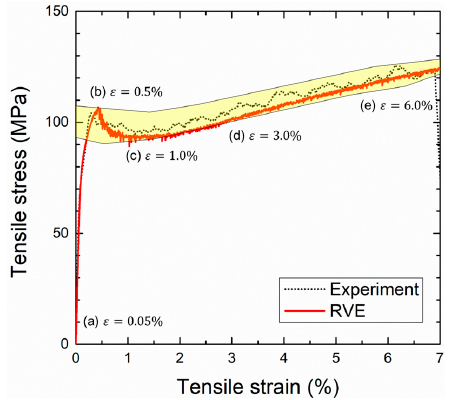
Figure 7. Typical stress–strain curves obtained by the experiment and representative volume element (RVE) model. The yellow-colored region indicates the deviation of the experimental results.